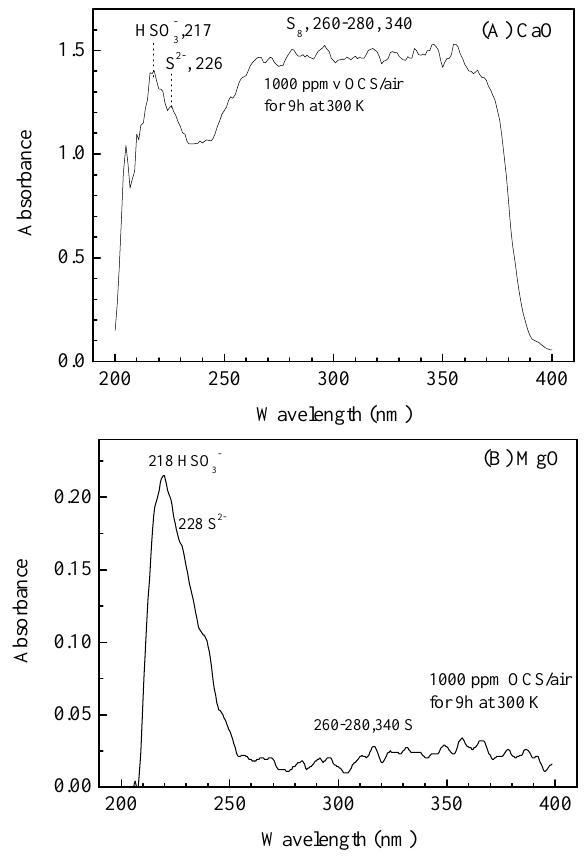
Fig. 5. Diffuse reflectance UV-vis spectra of (a) CaO, and (b) MgO after exposed to 1000ppmv of OCS in air for 9h.